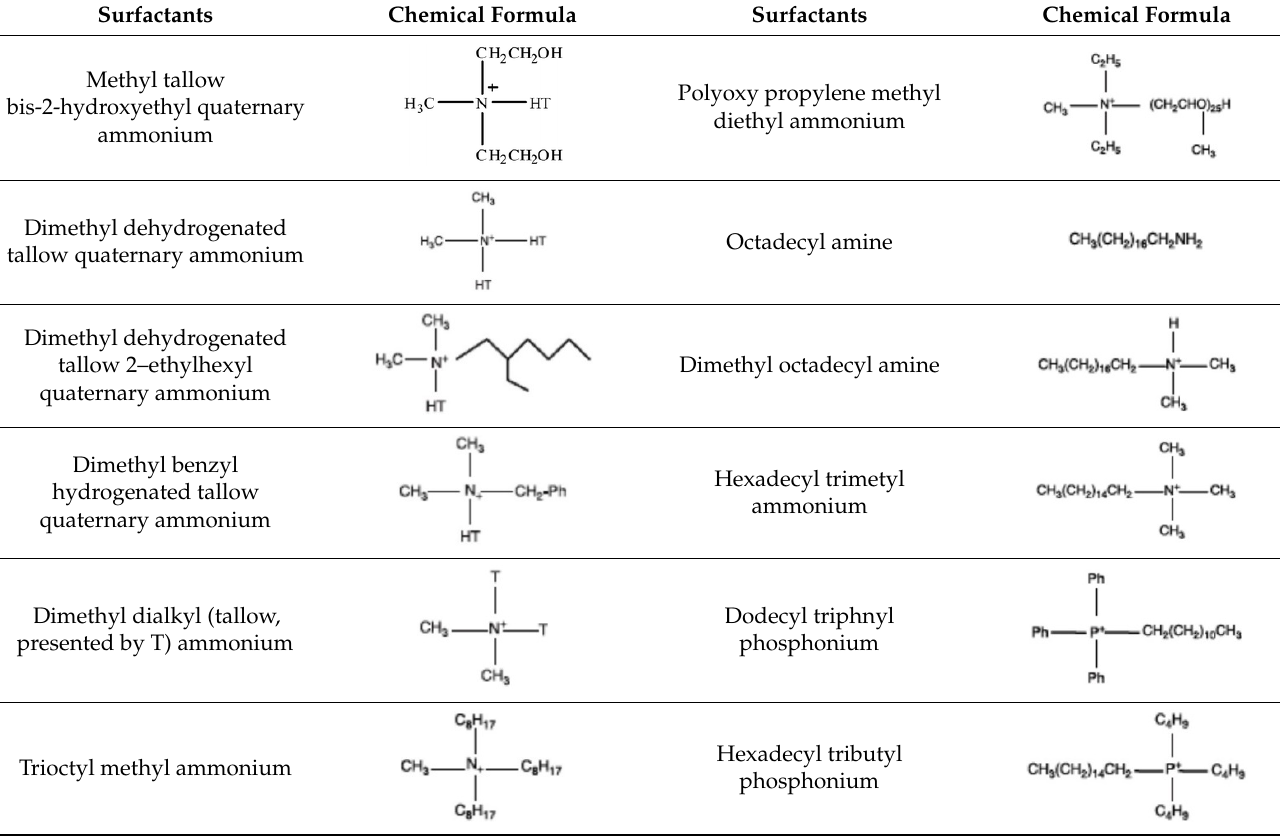
Figure 1. Swelling of Ca-montmorillonite and Na-montmorillonite in water [25]. Table 1. Chemical structures of the most commonly used surfactants for the modification of layered silicates [27].